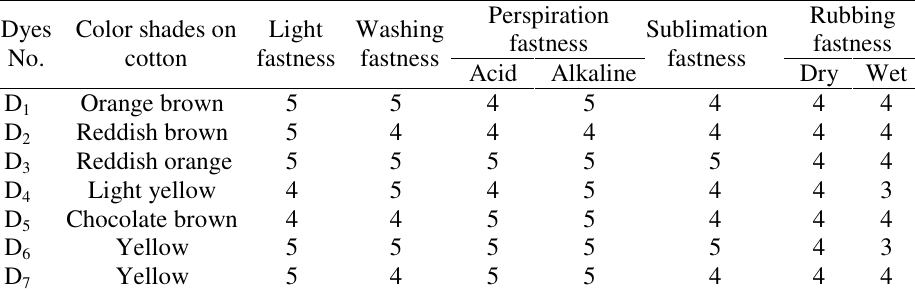
Table 2. Results of solvent dyes on printing and various fastness properties of dyes on